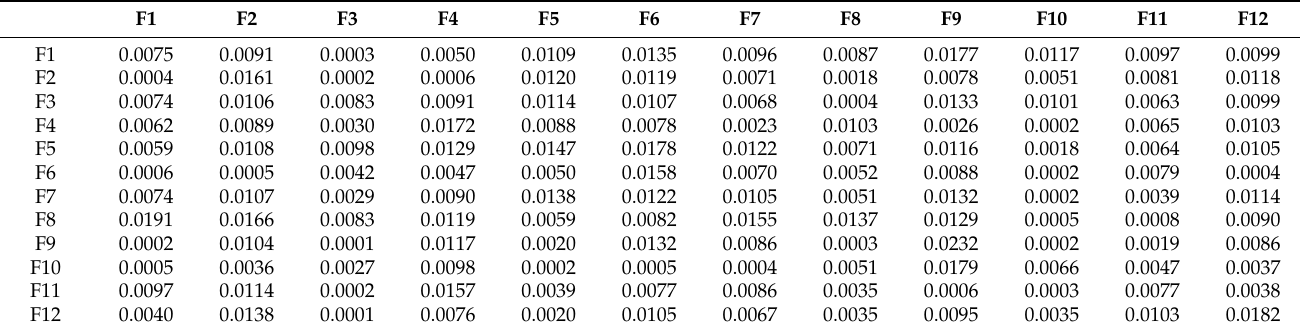
Table 11. The total strength–influence matrix.